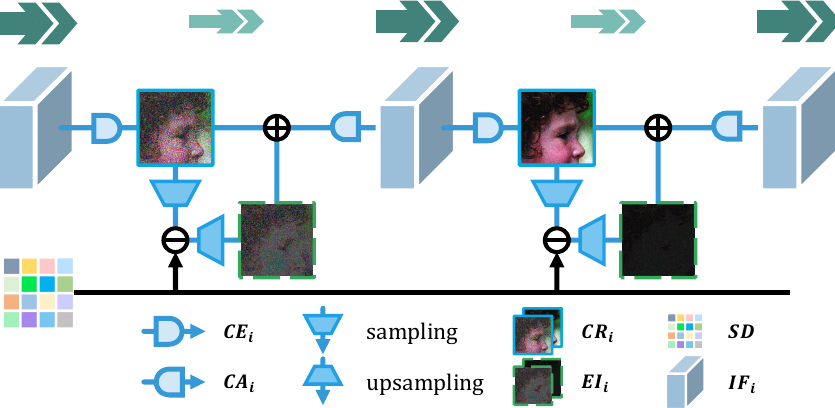
Figure 6. Base module in related works. CR i and error images EI i are represented as blue solid wire- frames and green dotted wireframes, respectively. The IF i is marked as blue cubes. The green double arrows mark the total number of feature maps, which can also be understood as the reconstructed information flow contained in the